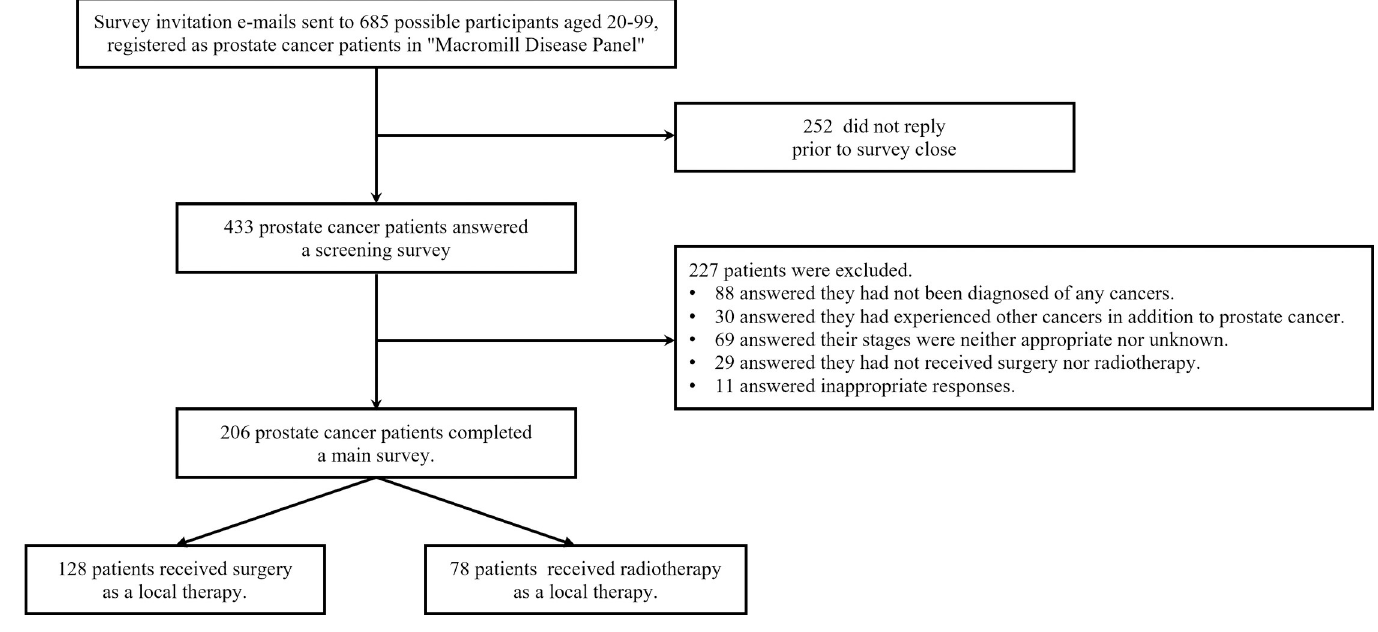
Fig 1. Flowchart of the data